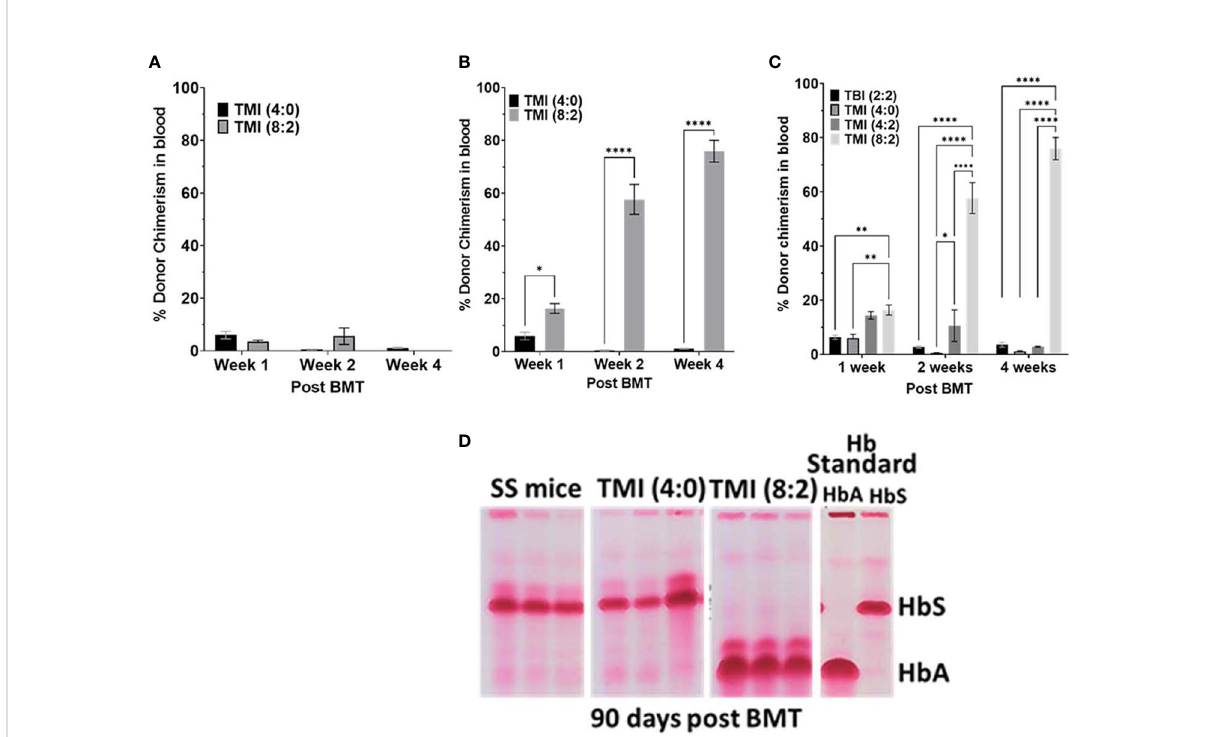
FIGURE 4 Effect of increasing donor cell number on chimerism and evaluation of blood hemoglobin for HbA and HbS. (A, B) The SS mice treated with TM (4:0) and TMI (8:2) transplanted with 10 million (A) and 25 million (B) AA donor BM cells and chimerism was measured in peripheral blood at D7, D14, and D30 post-BMT. (C) SS mice treated with different radiation doses were transplanted with 25 million AA donor BM cells and chimerism was checked at D7, D14, and D30 post-BMT in peripheral blood. Only TMI (8:2)-treated mice sustained chimerism at D30 post-BMT and was ~>65% ( n ≥ 3). (D) CAE electrophoresis analysis of HbA and HbS 90 days post-BMT in peripheral blood. SS mouse was treated with TMI (4:0) and TMI (8:2) (Day − 1) and 24 h later (Day 0) transplanted with 25 million donor AA BM cells. CAE analysis of TMI (8:2)- and TMI (4:0)-treated mice transplanted with 25 million cells on D90 post-BMT. Hb standard: from homozygous AA (HbA) and SS (HbS), and hemizygous AS (AFSC) mouse RBCs. Signi fi cance was determined using 2 way ANOVA and was considered signi fi cant when p value was < 0.05. * p<0.05, ** p< 0.01, ****